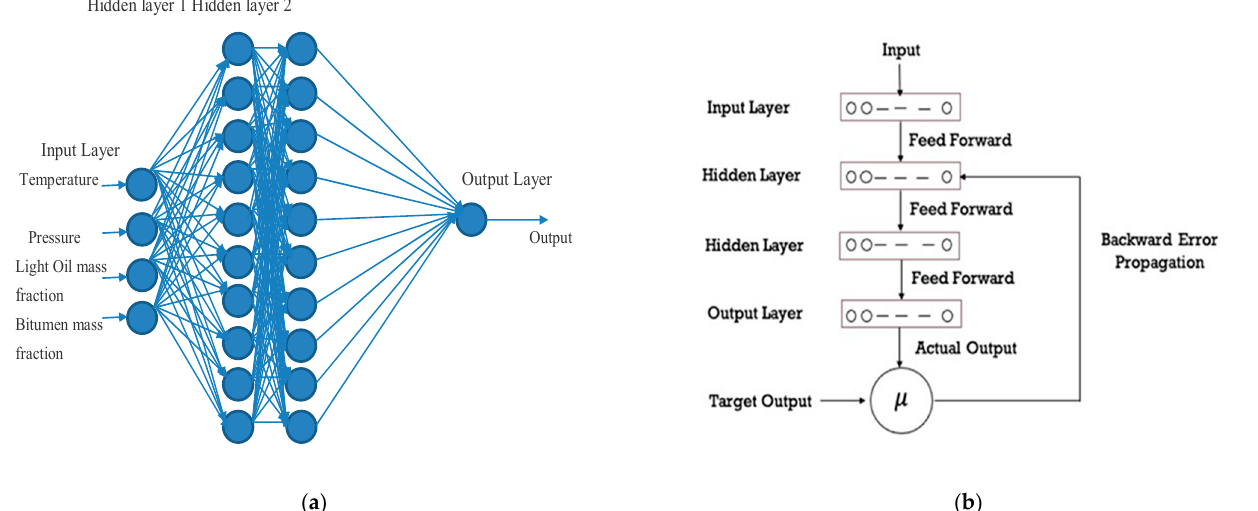
Figure 2. Schematic showing a typical structure for a feedforward neural network ( a ), and a flow chart of its operational procedure ( b ) .